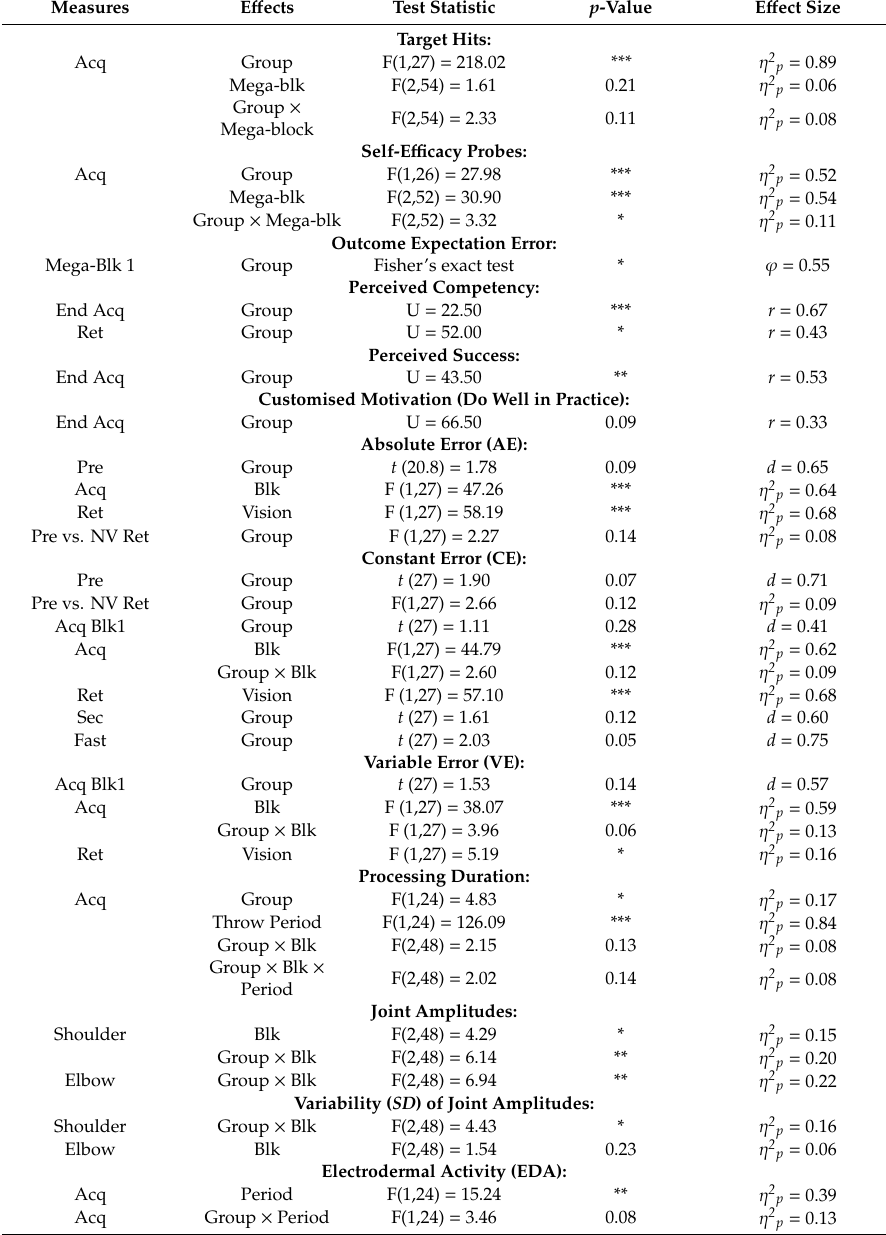
Table 3. Summary table of statistics (test statistic, p -value, and e ff ect size, either partial-eta squared, Cramer’s ϕ or Cohen’s d) for all main e ff ect and group-related interactions when Fs > 1.5 or t >